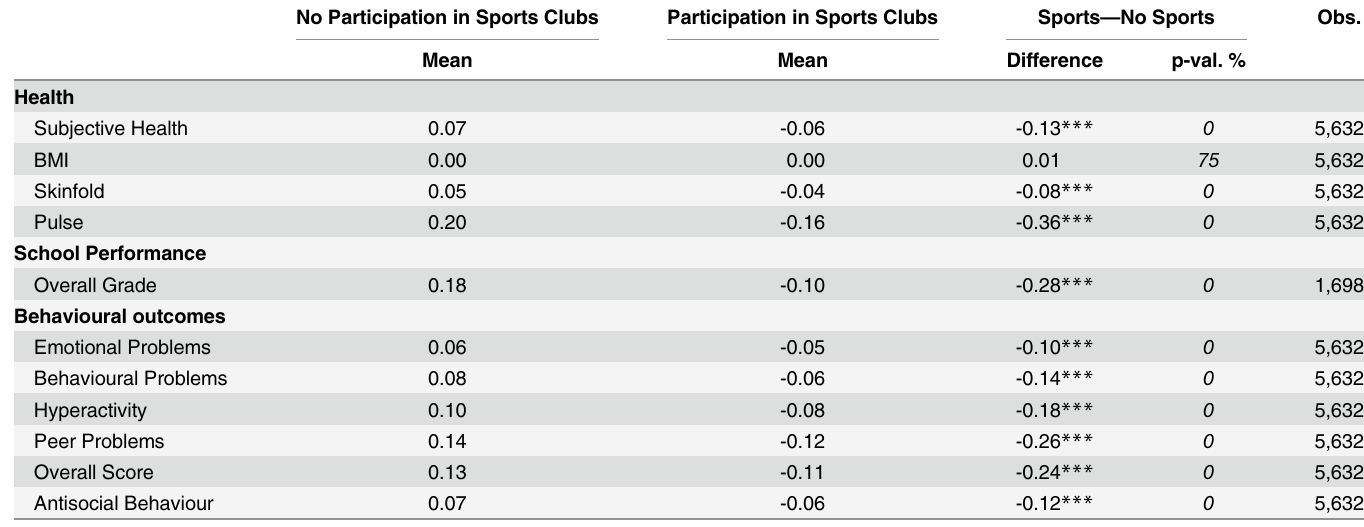
Table 3. Descriptive statistics for children's health and human capital. Note: All outcome variables are standardized to mean zero and variance one. A lower value corresponds to a better outcome. The lower number of observations for grades appears because not all children are enrolled in school and not all school-age children receive grades. P-values stem from two-sided t-tests comparing the means for children doing and not doing sports in a club. Descriptive statistics of the unstandardized variables can be found in S6